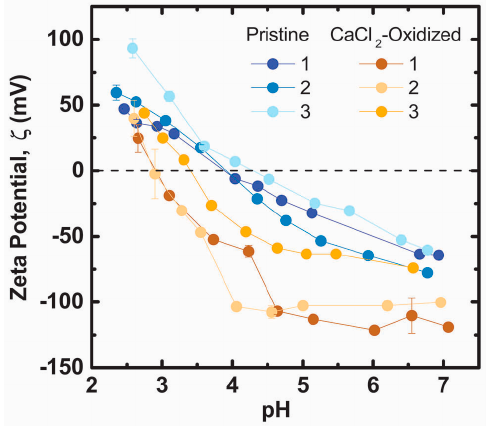
Figure 5. ζ potential titrations of pristine PDA films and PDA films that were incubated in 300 mM CaCl 2 50 mM Tris buffer pH = 9.5 for four hours. Numbers 1–3 designate unique samples.